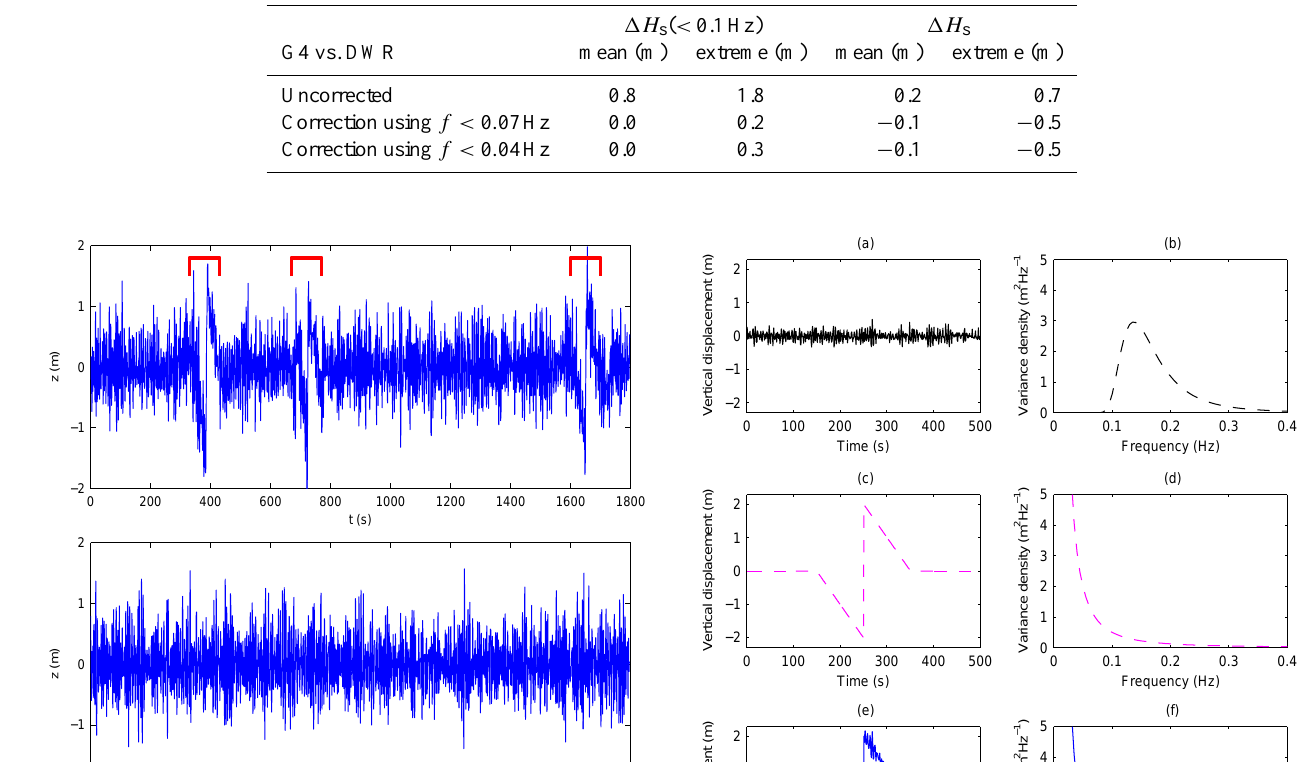
Table 1. Mean and extreme difference in significant wave height of the G4 wave buoy when compared to the DWR wave buoy. The significant wave height is calculated for both the entire frequency range and for the low-frequency part of the spectra only. Two corrections are made using different maximum frequencies to quantify the erroneous energy. Values are calculated from data where erroneous energy was present (i.e. the correction by the method was at least 0.1m).